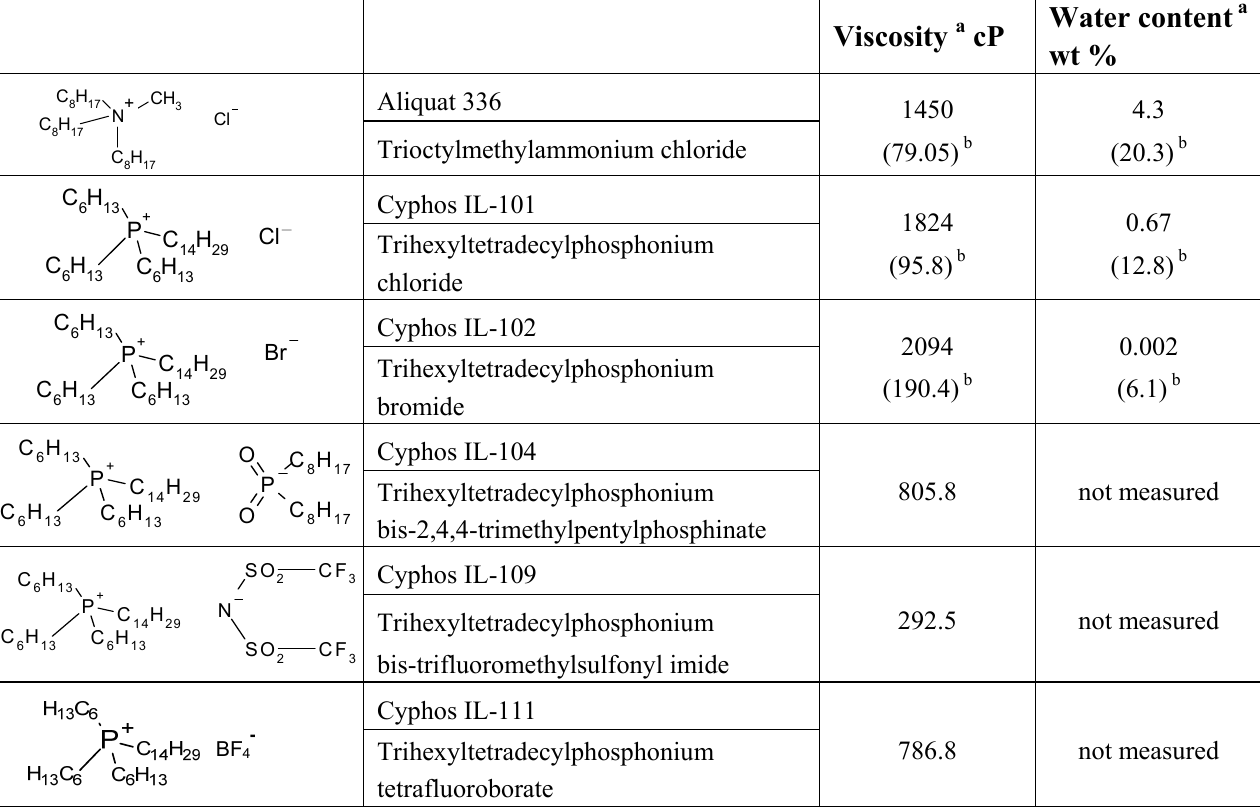
Table 1. Molecular structure and properties of the ionic liquids used in this